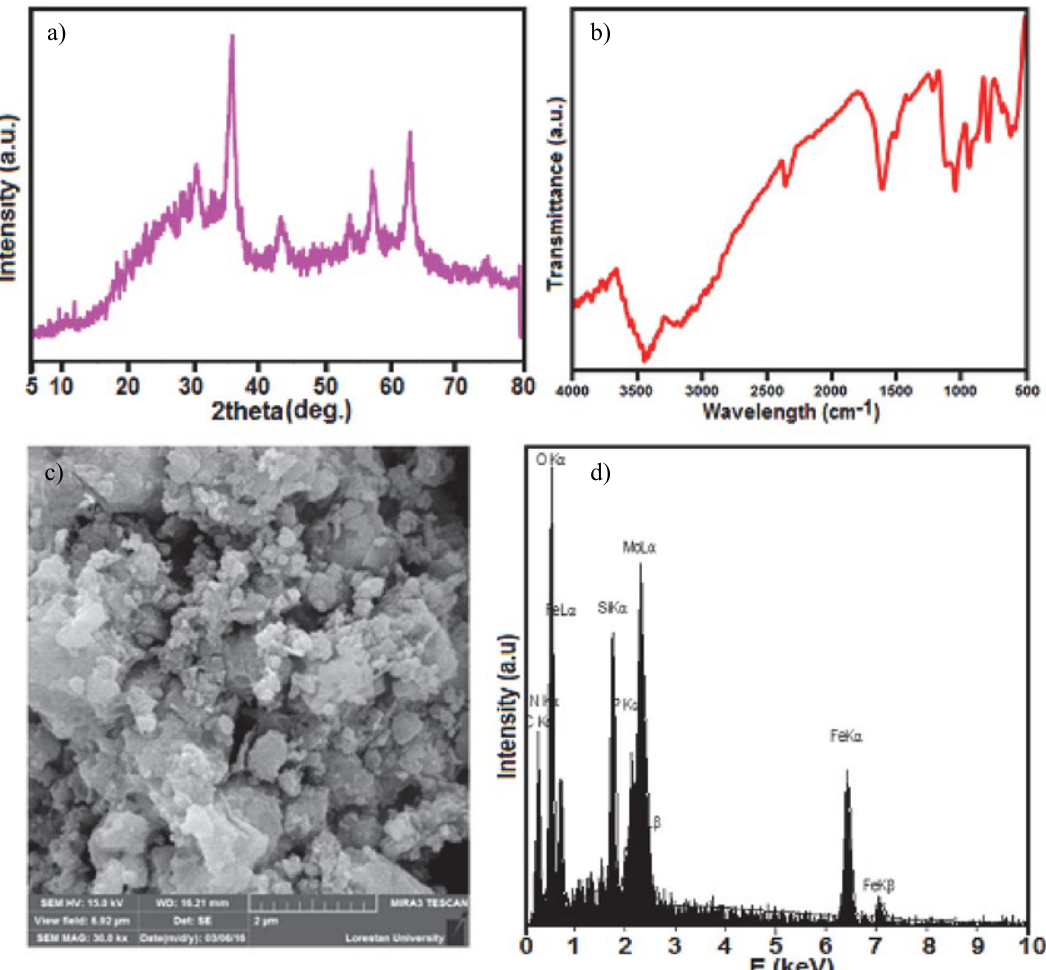
Figure 14. (a) XRD pattern, (b) FT-IR spectrum, (c) SEM image, and (d) EDX spectrum of the recovered Fe material after the fourth